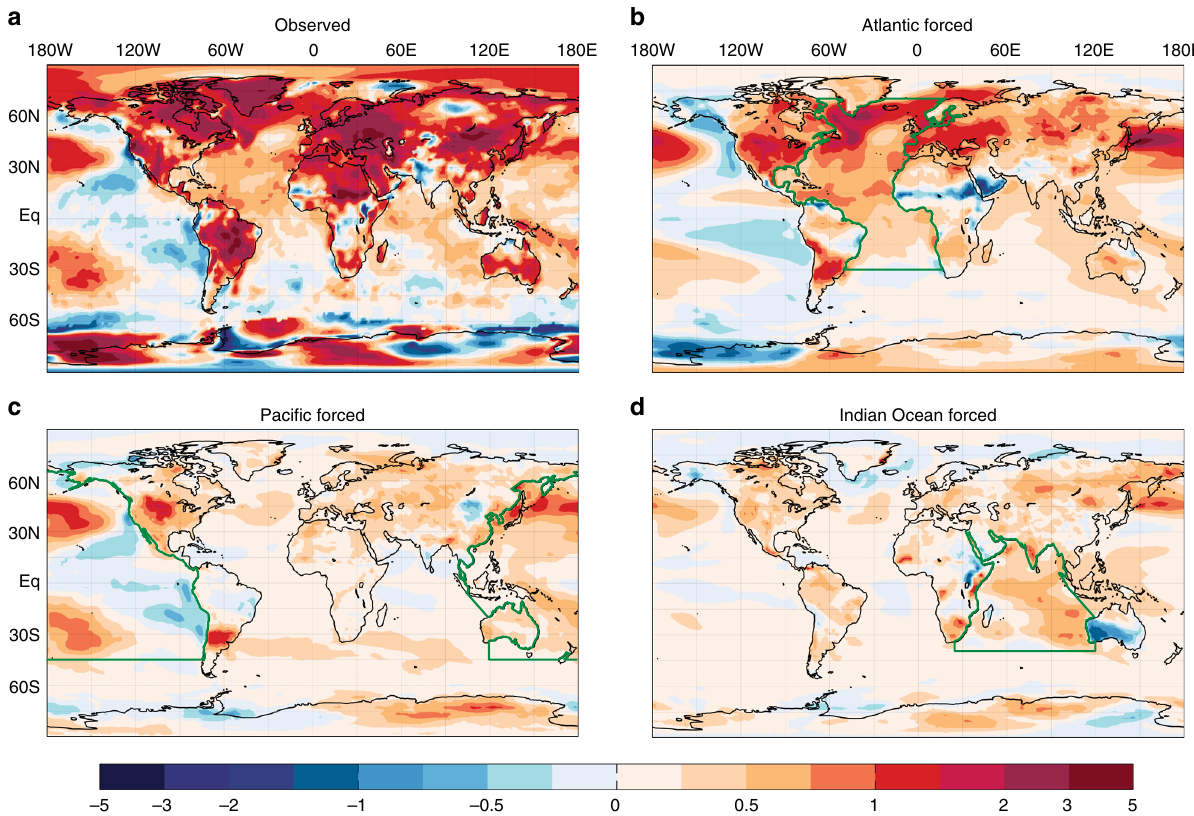
Fig. 7 Summertime 1979 – 2012 surface temperature trends forced by ocean basin SSTs. a The observed summertime (June – September) 1979 – 2012 seasonally averaged daily maximum surface temperature trend (°C [34 yr] − 1 ), where values over land and regions of sea ice are derived from the ERA-Interim reanalysis and values over all other ocean regions are derived from HadISST. b – d The surface temperature trend over the same period derived from CESM1 simulations with SSTs nudged to HadISST over the Atlantic ( b ), Paci fi c ( c ), and Indian Oceans ( d ). The regions outlined in green de fi ne the locations of SST nudging (see